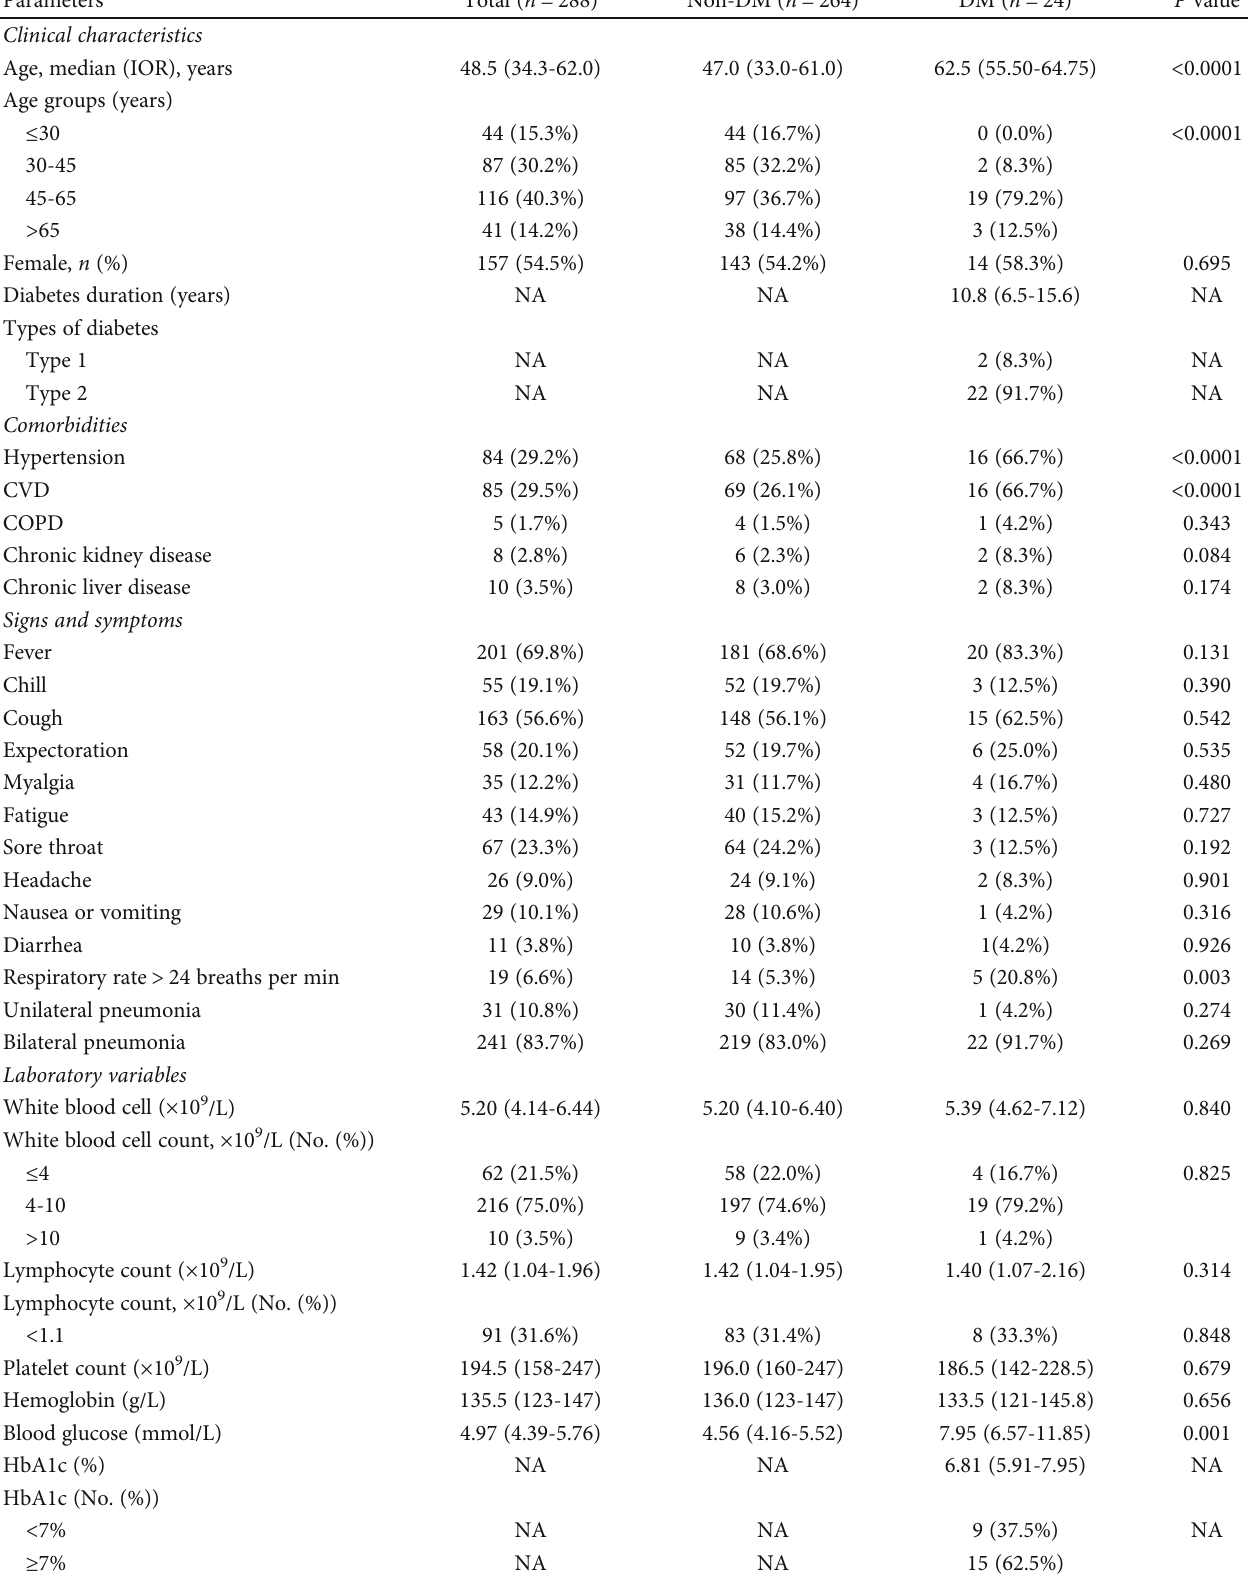
Table 1: Clinical features of COVID-19 patients with non-DM or